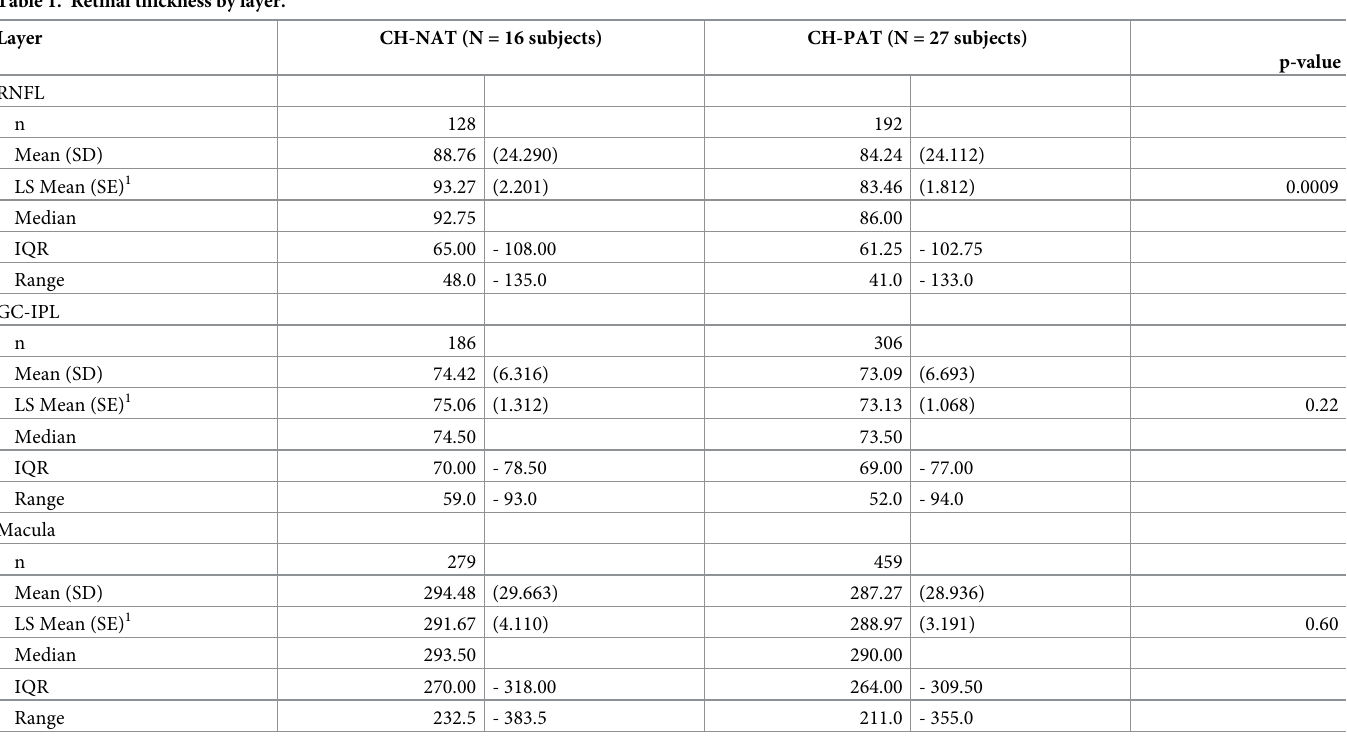
Table 1. Retinal thickness by